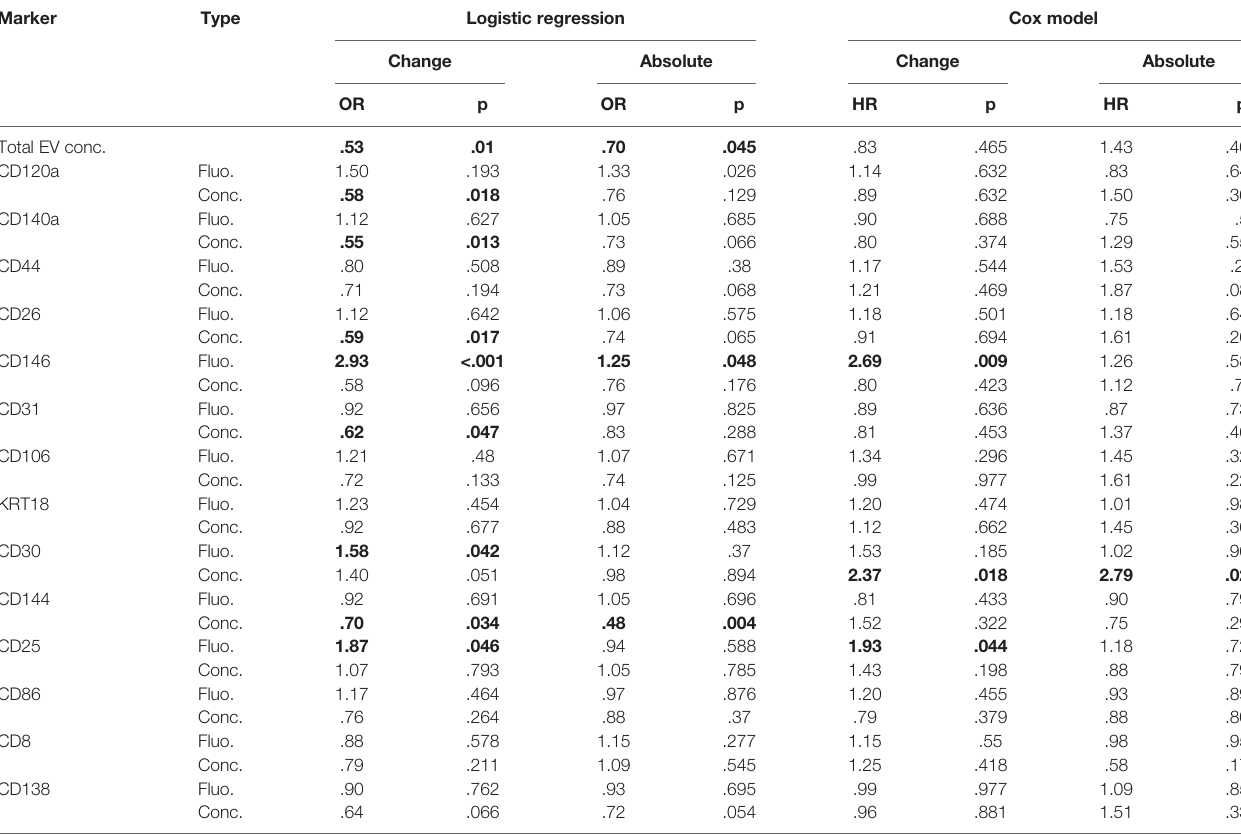
TABLE 2 | Association between EV surface biomarker level and aGvHD. Marker Type Logistic regression Cox model Change Absolute Change Absolute OR p OR p HR Total EV conc. .53